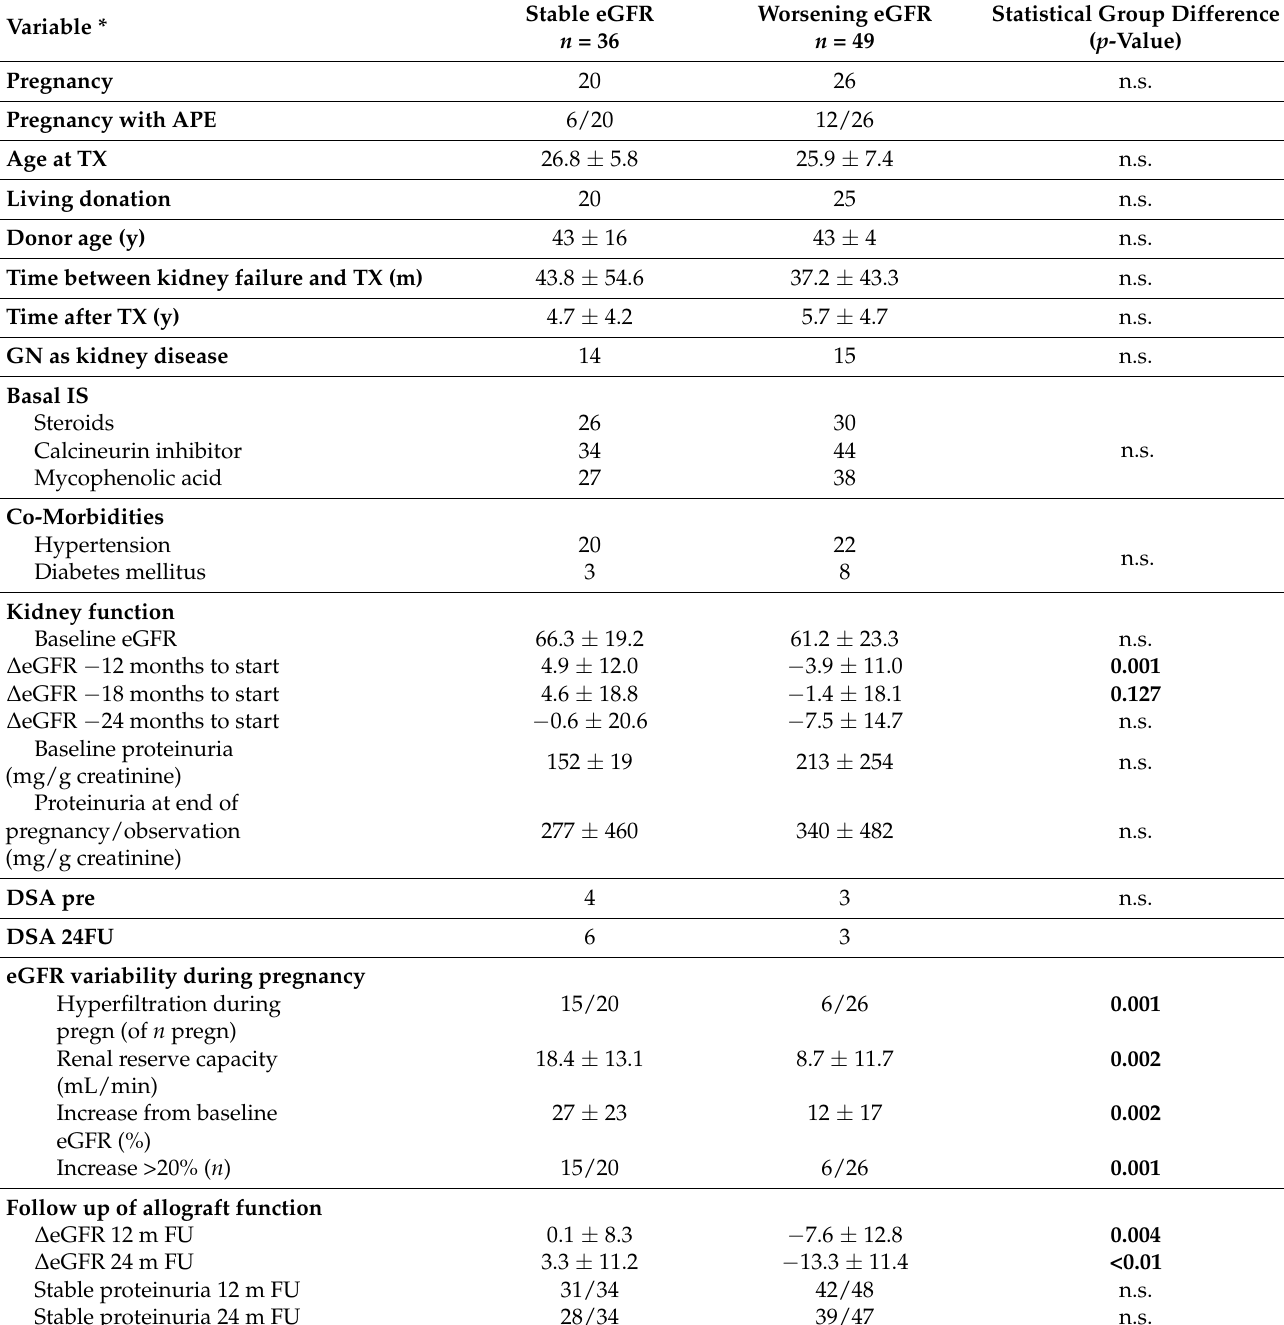
Table 5. Characteristics stratified by status for adverse pregnancy